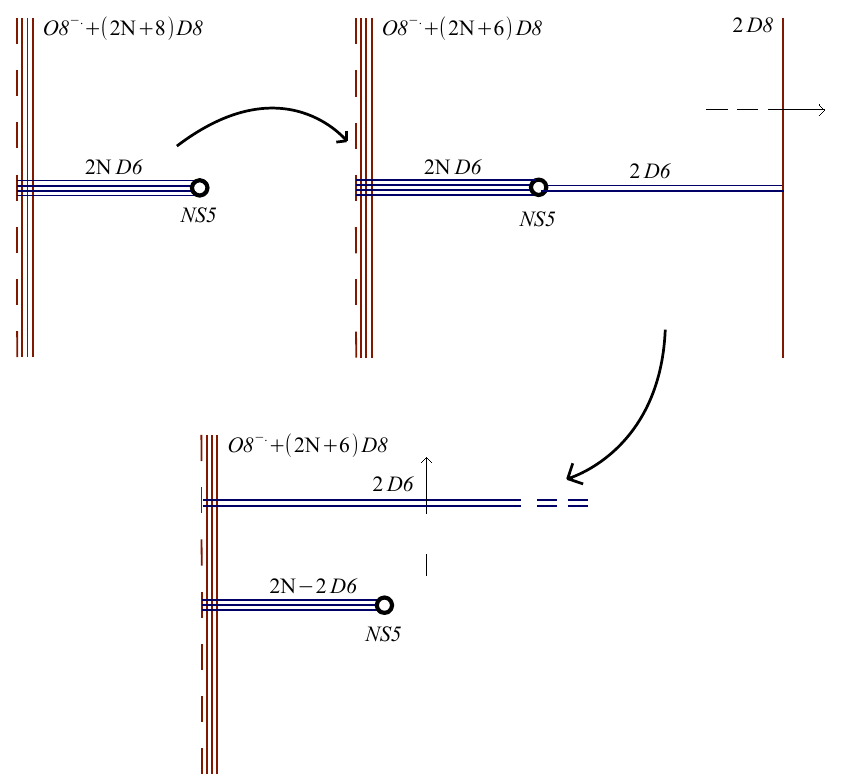
Figure 15. Higgsing of the 1 theory to the 1 theory. Higgsing can be performed by Sp( N ) Sp( N (cid:0) 1) moving a pair of D8 branes to in(cid:12)nity past the NS5 brane, which creates two additional D6 branes via a Hanany-Witten transition [192]. The new D6 branes combine with two of the already existent D6 branes and are also moved o(cid:11) to in(cid:12)nity, lowering the overall number of D6 branes to 2( N (cid:0)